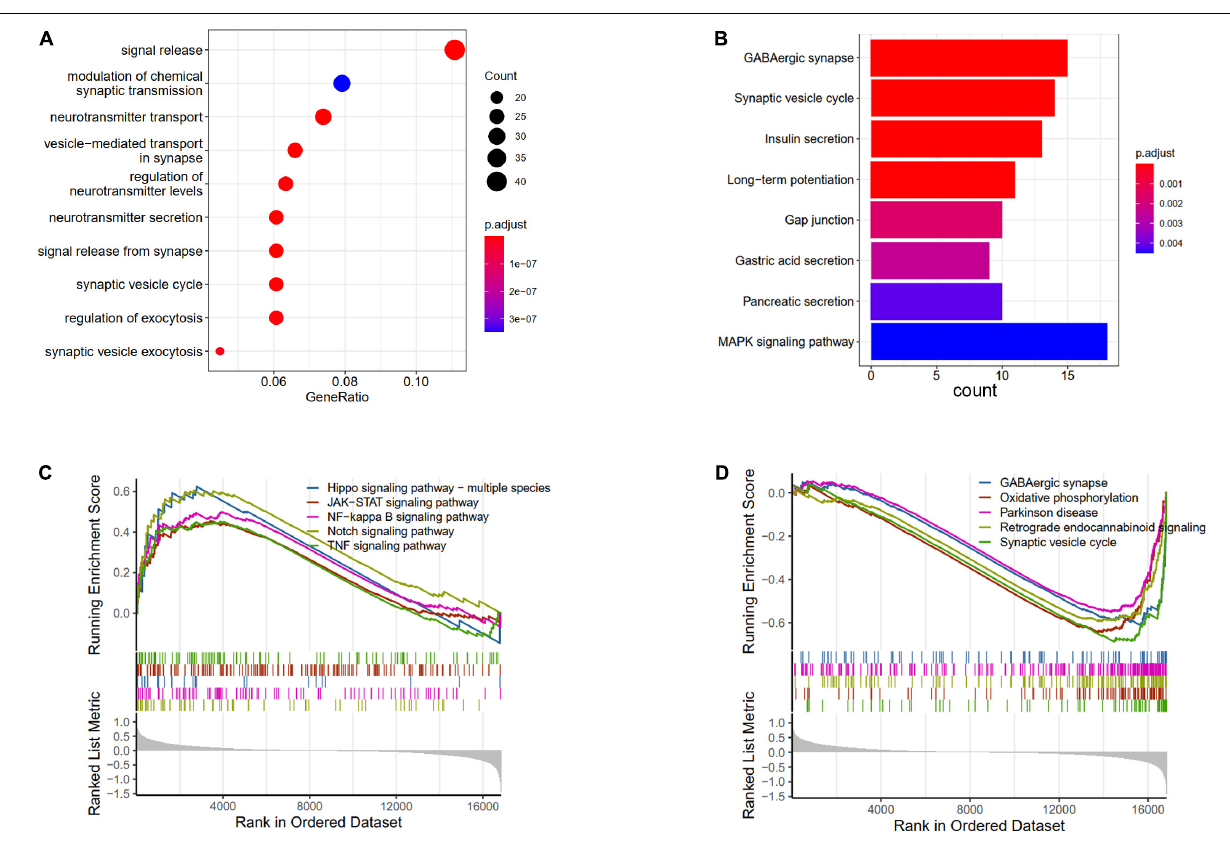
FIGURE 3 | Enrichments analysis of DEGs between AD and ND. (A) GO biological processes of DEGs. (B) KEGG terms of DEGs enriched. GSEA results of upregulated (C) and downregulated (D)